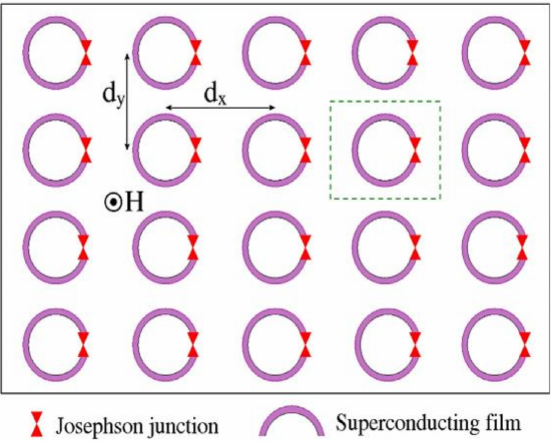
Figure 5. Schematic representation of SQUID metamaterial (Figure from Ref.